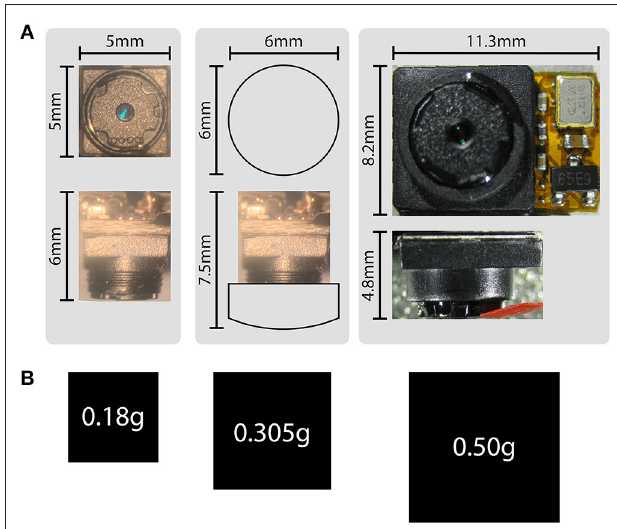
FIGURE 5 | Size and weight comparisons. (A) Size comparisons between the analog camera modules (left), analog camera modules with an additional collimating lens (middle), and an Adafruit 1937 picam camera module (right). The factory-installed adjustable lens has 1mm of travel, and is shown maximally extended (left, for a total camera depth of 6mm), and minimally extended (middle, for a camera depth of 5mm, or 7.5mm with the additional collimating lens). Broader views of the camera modules are also shown in Appendices 1, 2 . (B) Weight comparisons represented by area for the corresponding camera modules shown in (A) .